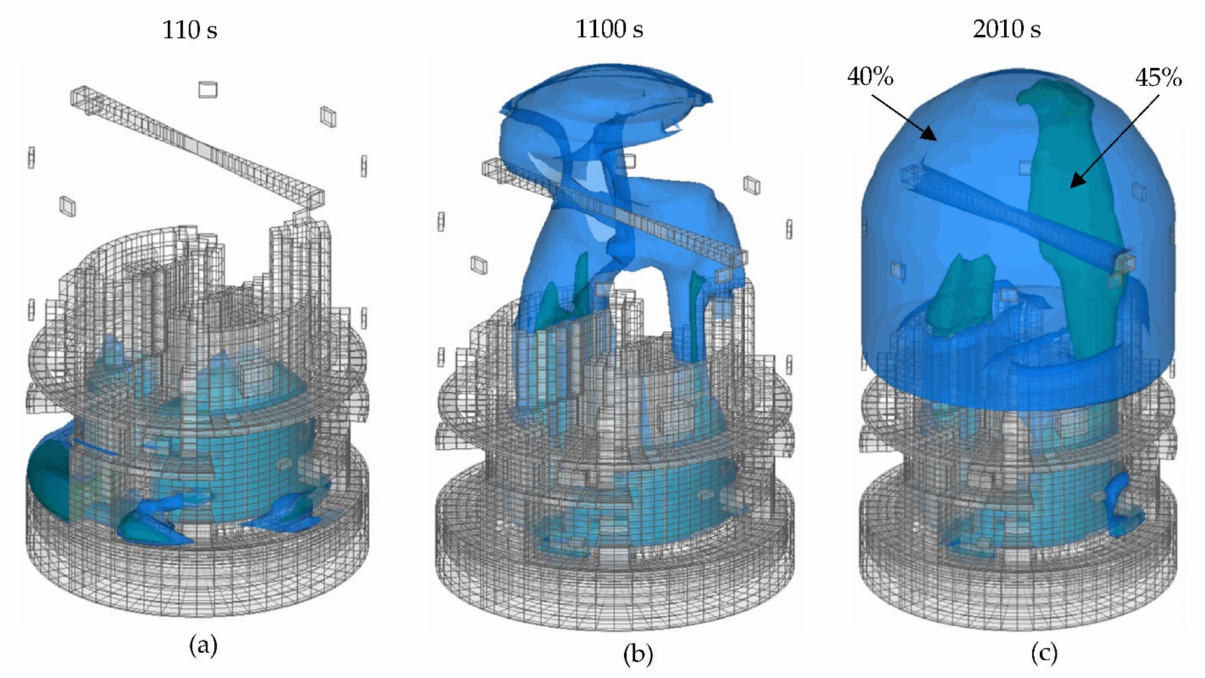
Figure 4. Iso-surface of steam concentrations according to time variation.